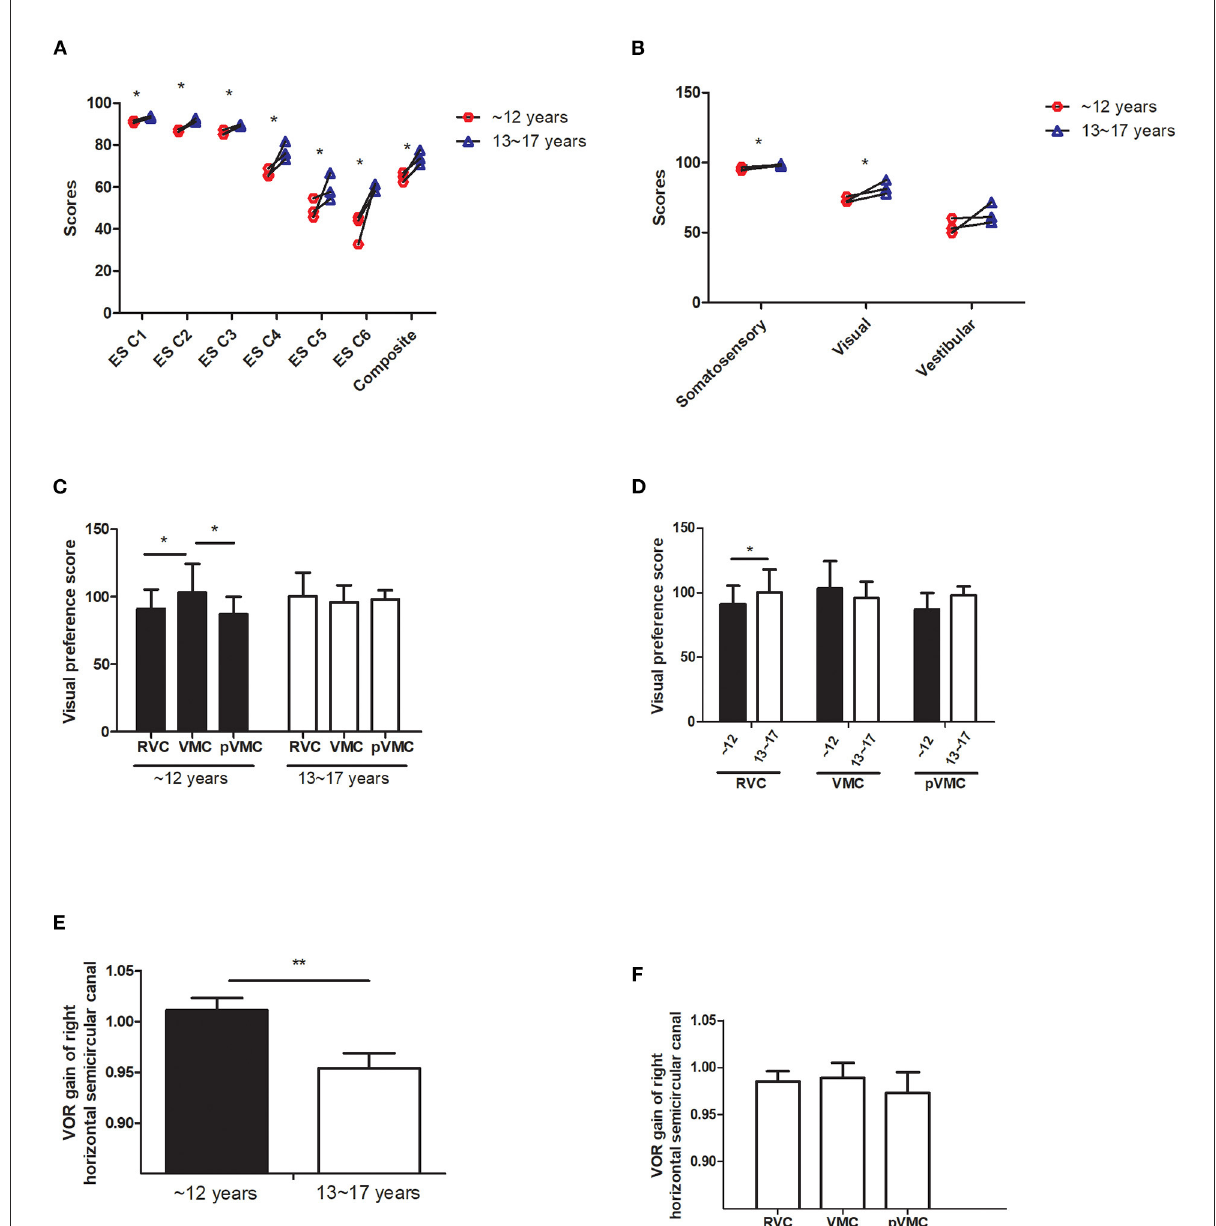
FIGURE2 Sensory organization test analysis. (A) Equilibrium score. (B) Sensory ratio analysis. (C,D) Visual preference score in different age groups and diseases. (E,F) VOR gain value of horizontal semicircular canal in different age groups and disease.ES C, Equilibrium score condition; SS C, strategy score condition; VMC, vestibular Migraine of Childhood; pVMC, probable Vestibular Migraine of Childhood; RVC, Recurrent Vertigo of Childhood; VOR, vestibular ocular reflex. * P < 0.05, ** P <